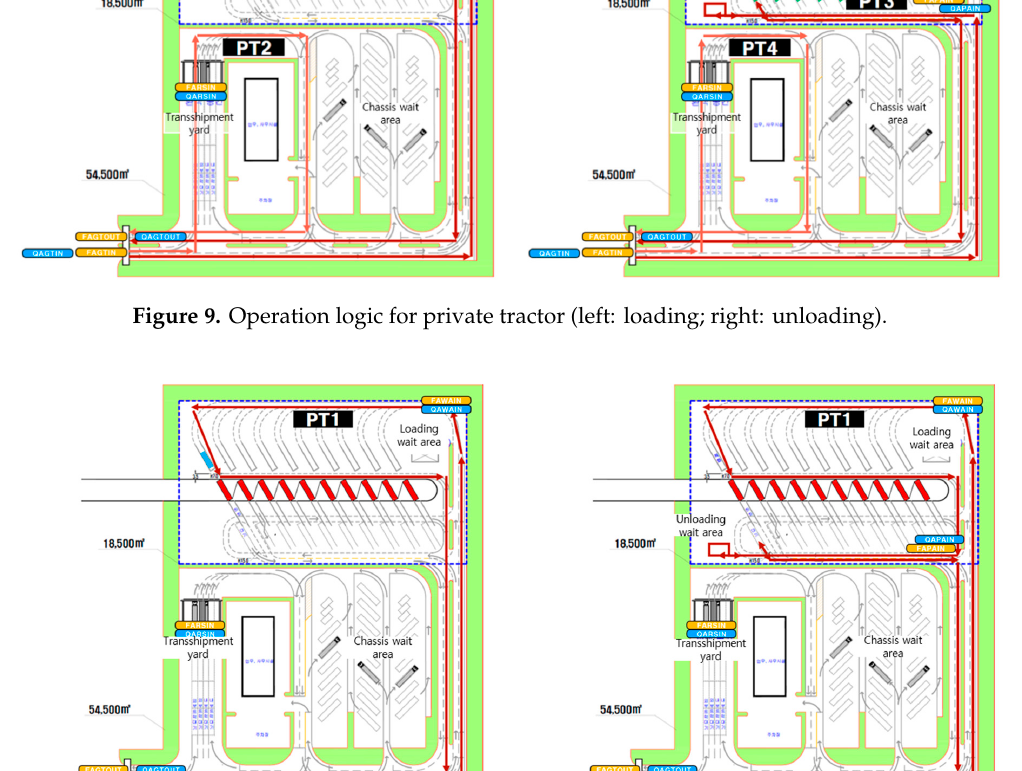
Figure 10. Operation logic for private tractor (left: loading scenario 1; right: loading and unloading scenario 2).